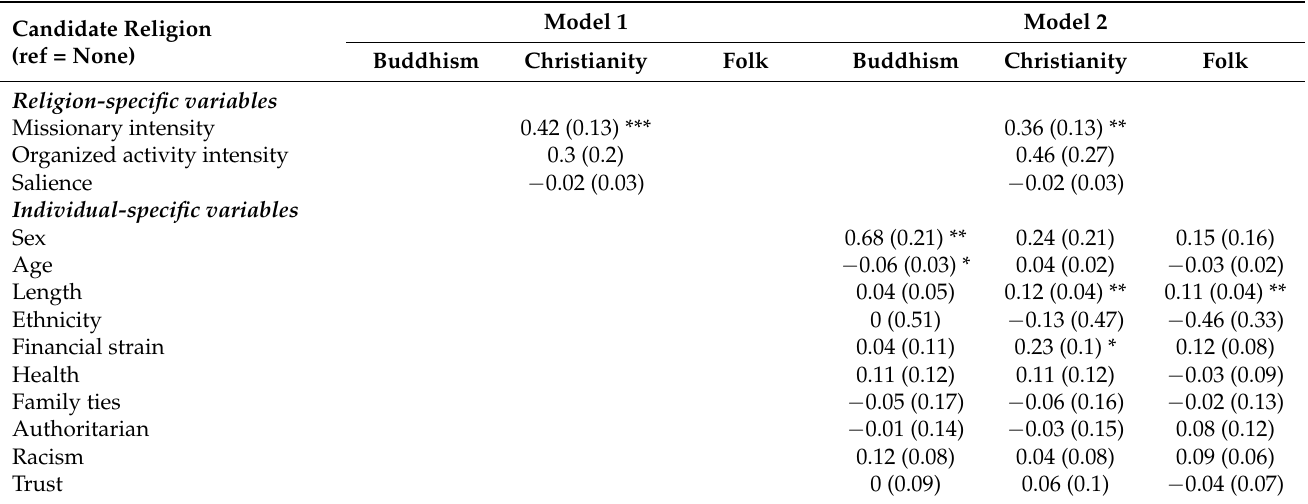
Table 5. Mixed logit model of intergenerational religious changes between mother’s religion and child’s current